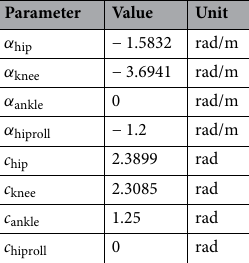
Table 4. Obstacle avoidance